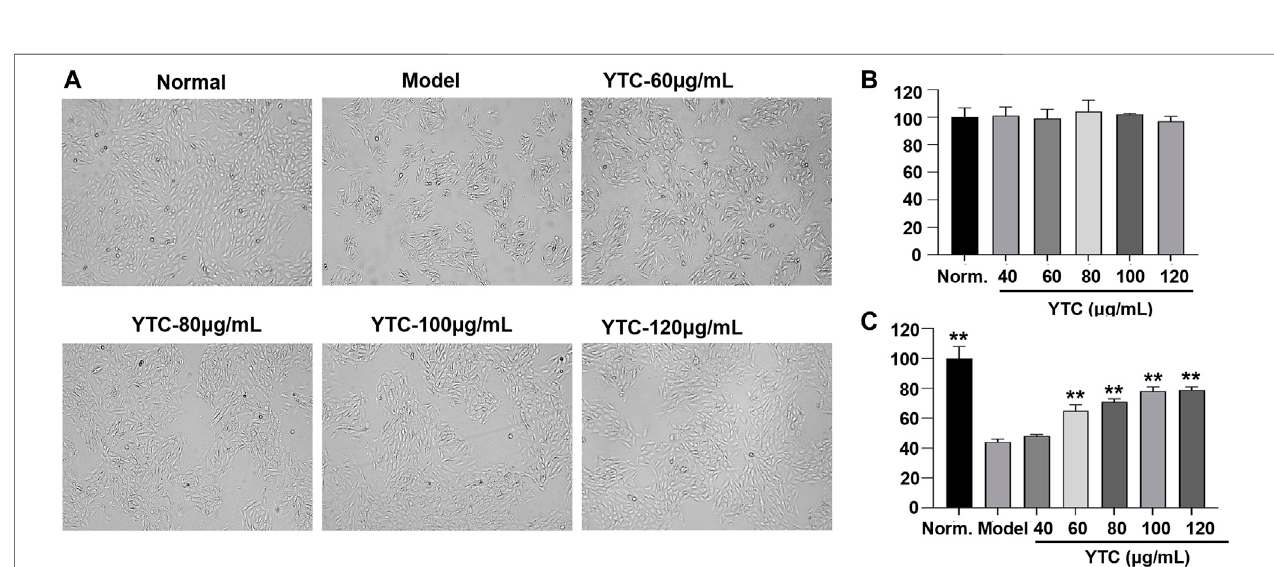
FIGURE5| Protective effectsofYTC onthe cellviability ofH 2 O 2 -stimulatedH9c2 cells. (A) The represented cellmorphology ofH9c2 cells withdifferent treatment. (B) Effects of YTC on cell viability of normal H9c2 cell. (C) Effects of YTC on cell viability of H 2 O 2 -stimulated H9c2 cells under different concentration. The values were represented as the mean ± SD ( n = 3). pp p < 0.01 vs the model group.